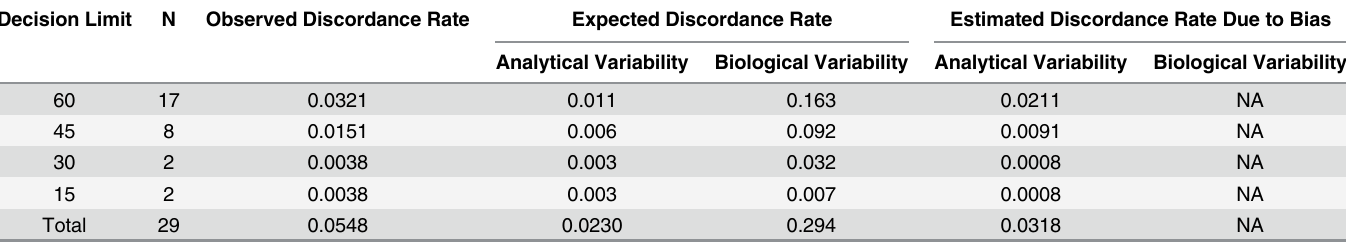
Table 3. Analysis of expected discordance